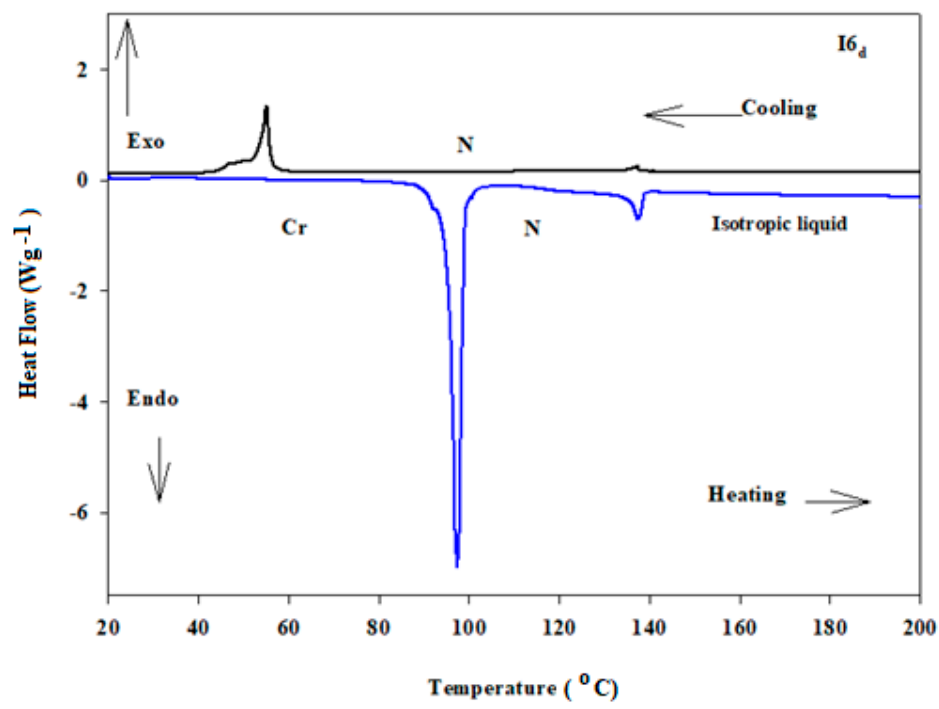
Figure 2. DSC thermograms of compounds I6 d at a rate of ± 10 ◦ C min − 1 recorded from the second heating and cooling cycles .